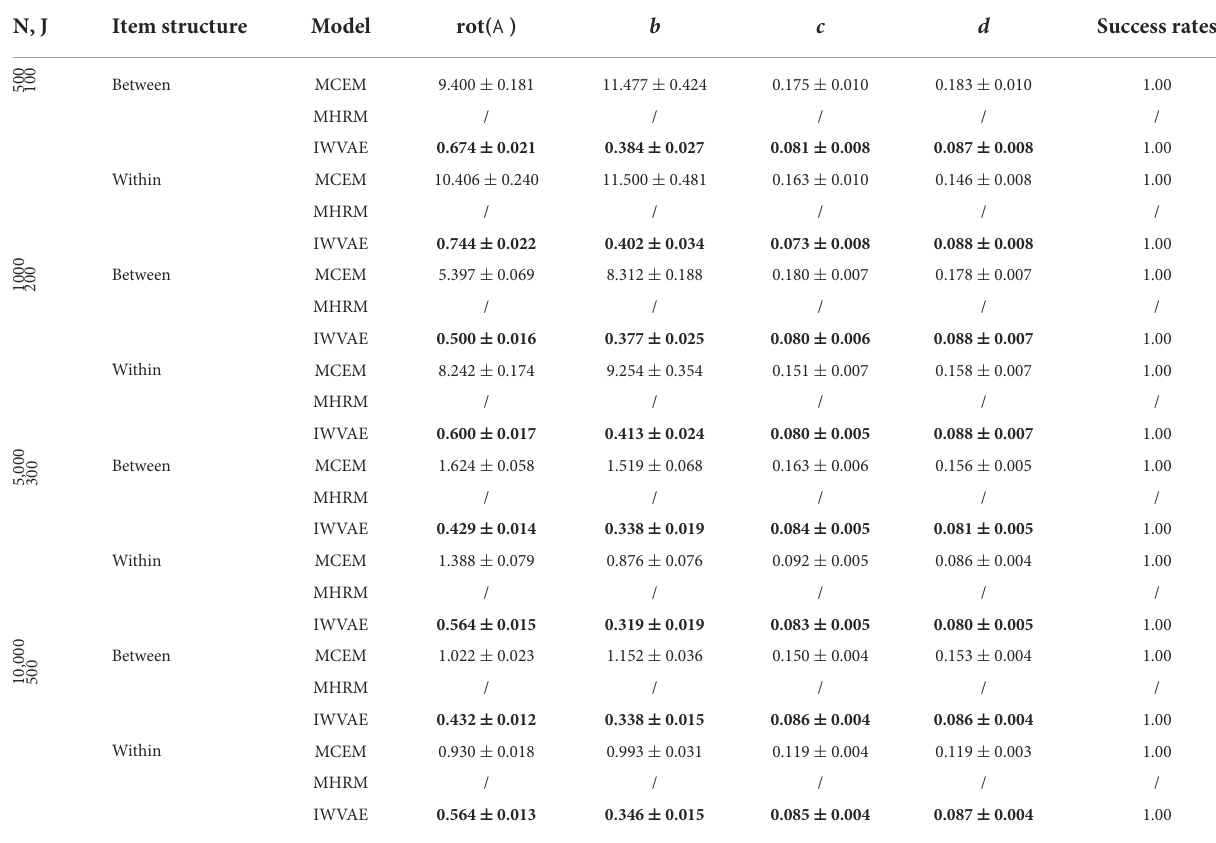
TABLE 2 Mean and SE of RMSE of M p estimate on M4PL models under double regime setting, best results are in bold. N, J Item structure Model Success rates